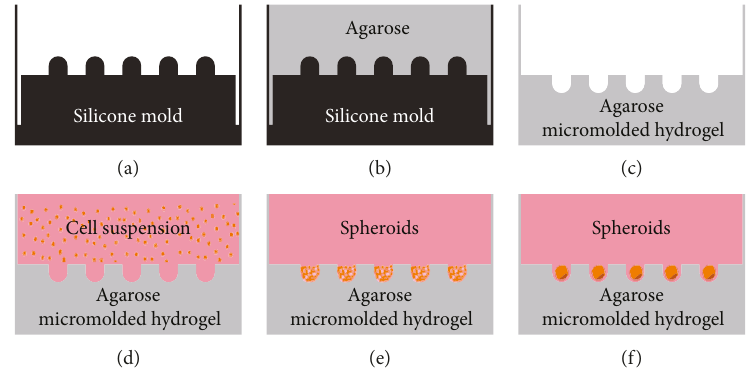
Figure 1: Scheme of cartilage progenitor cell spheroid culture. (a) Silicone molds were used from MicroTissues 3D Petri Dish. (b) The agarose solution was dispensed into silicone molds, resulting in the micromolded nonadhesive agarose hydrogel (c). (d) The cell suspension was carefully seeded into cell seeding chamber with single pipetting. (e) The cell suspension decanted into circular recesses after few minutes resulting in spheroids after 18 hours